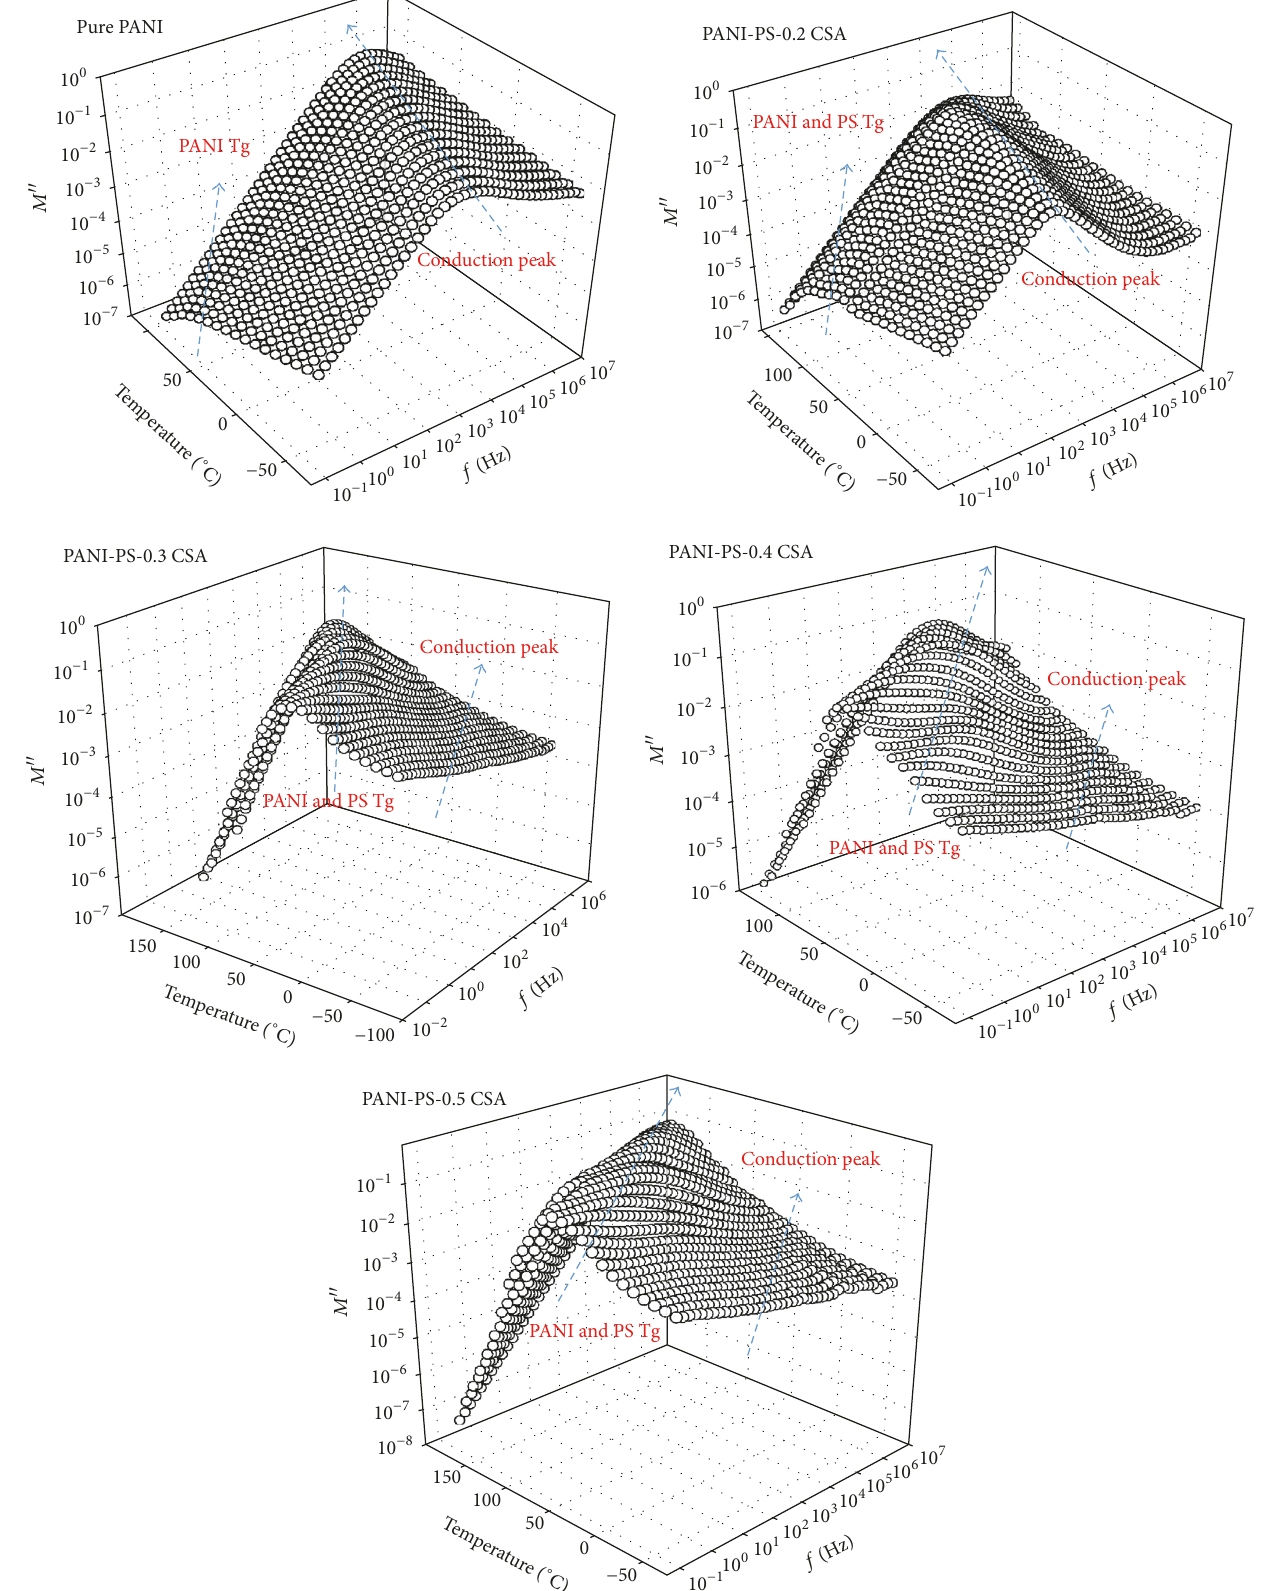
Figure 2: 3D plots of the electrical modulus versus temperature and frequency for the